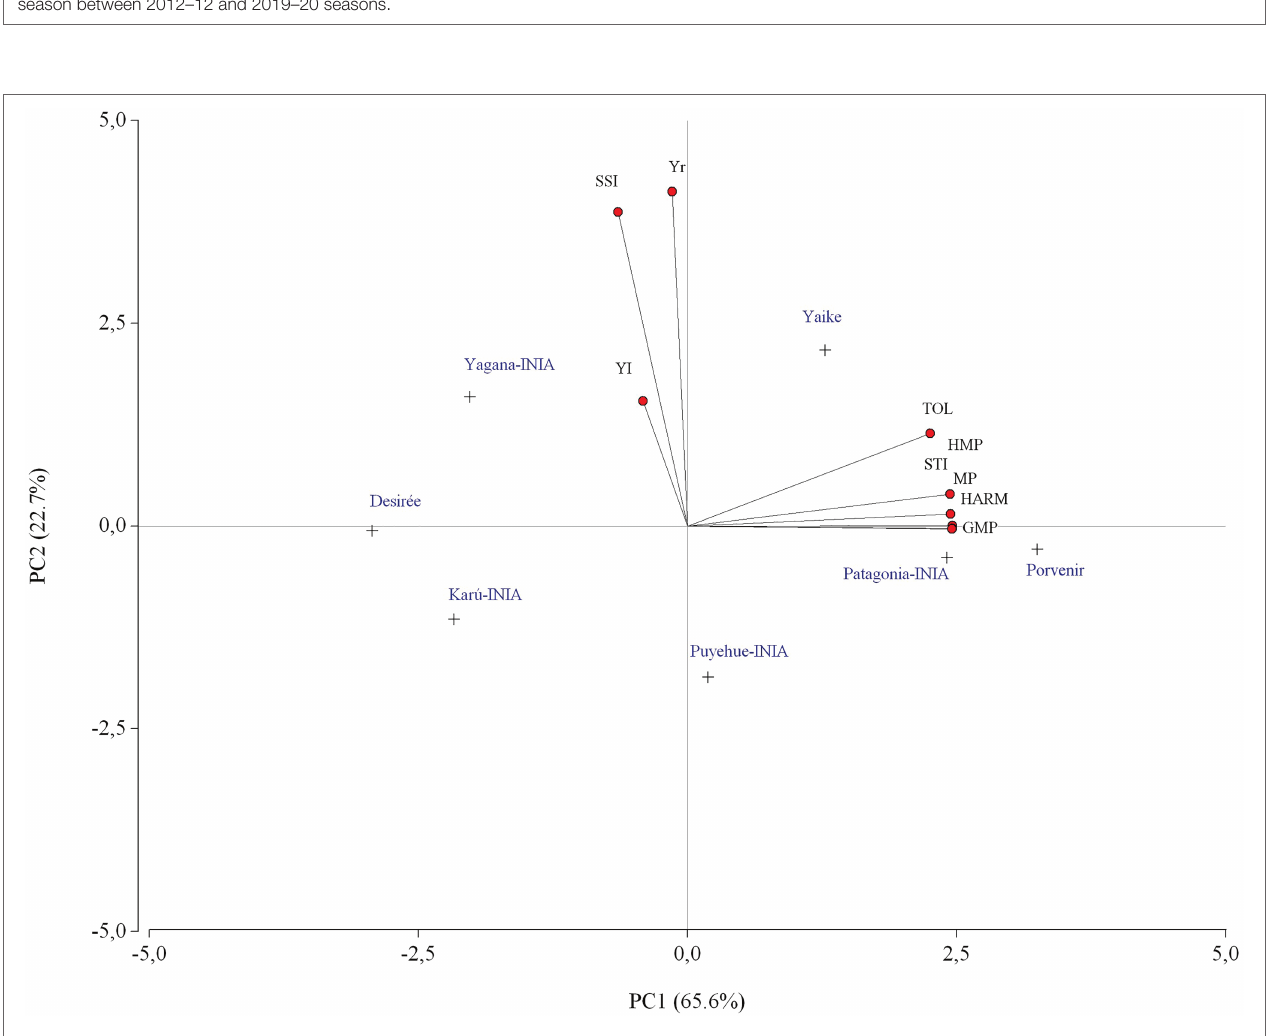
FIGURE 7 | Percentage of reduction of the yield under rainfed conditions compared to irrigated plots concerning the accumulated precipitation during the growing season between 2012–12 and 2019–20 seasons.